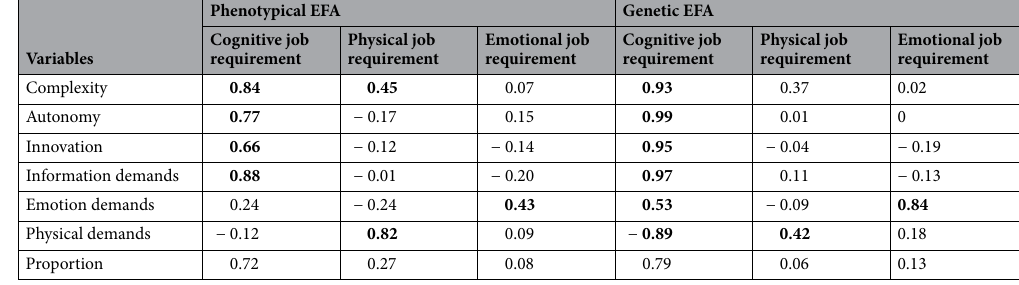
Table 2. Phenotypic and genetic EFAs of six job attainment characteristics in the UK Biobank discovery data. Factor loadings are standardized; factor loading higher than 0.40 are highlighted in bold. EFA Exploratory factor